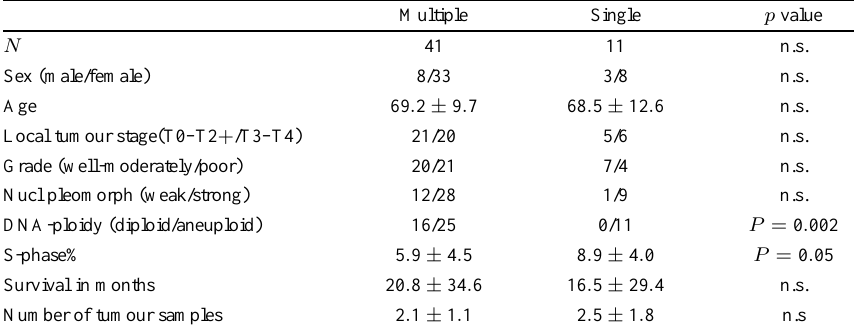
Stone number related to sex, age, T-classification, grade, nuclear pleomorphism, DNA ploidy and